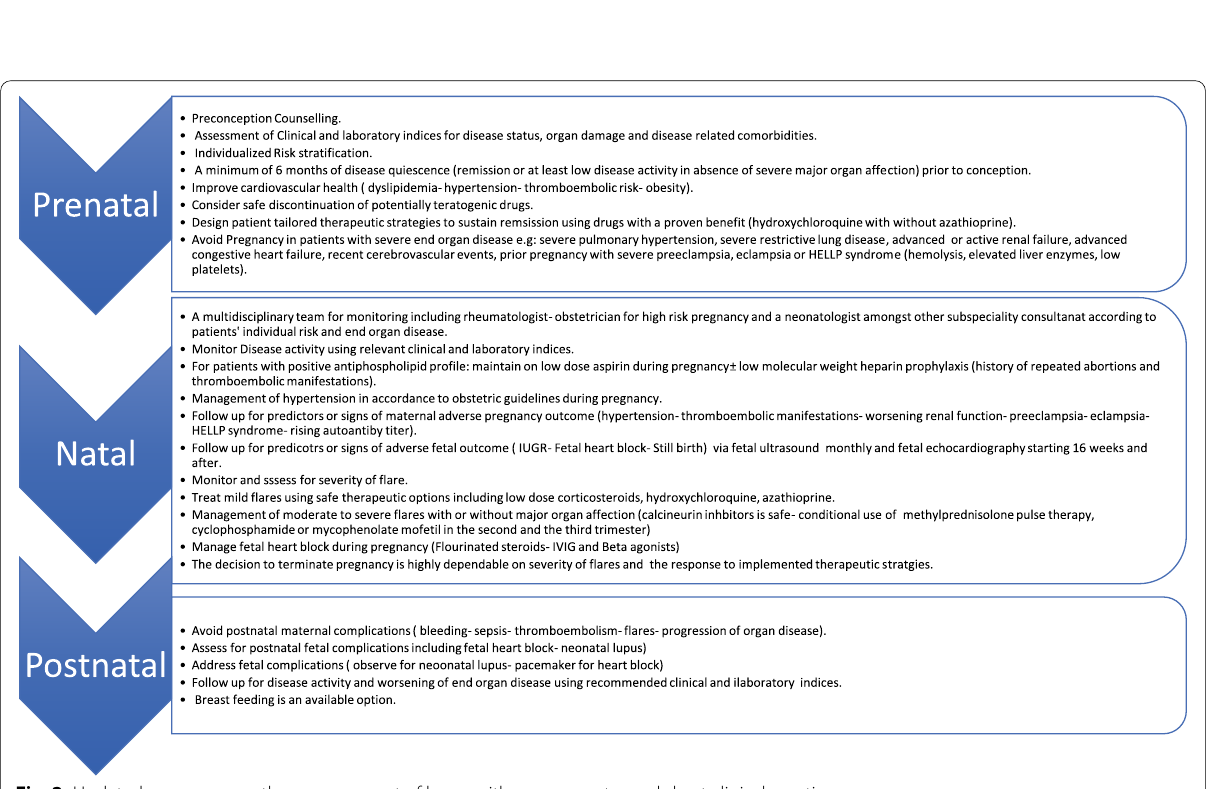
Fig. 2 Updated consensus on the management of lupus with pregnancy towards best clinical